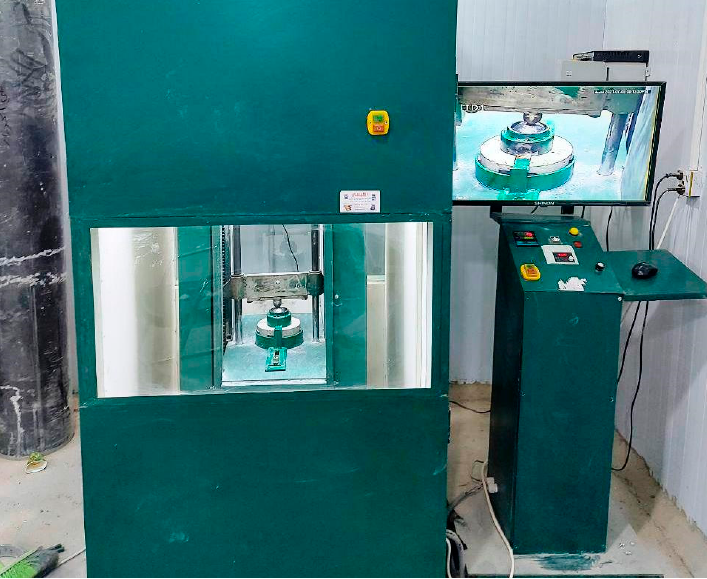
Figure 5. The repeated impact automatic testing machine.